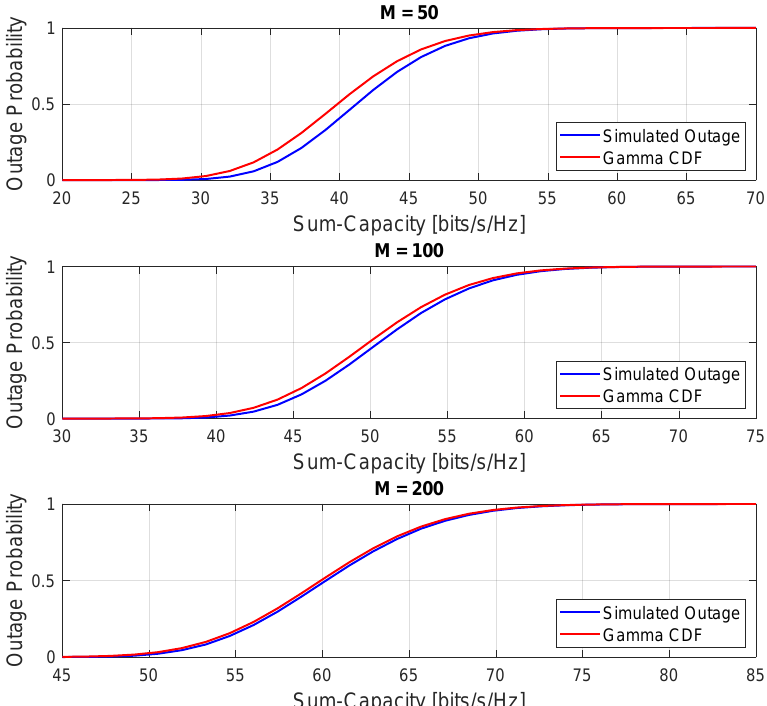
Figure 9. Comparison between the approximated and simulated outage probabilities in the high-SNR regime and favorable propagation